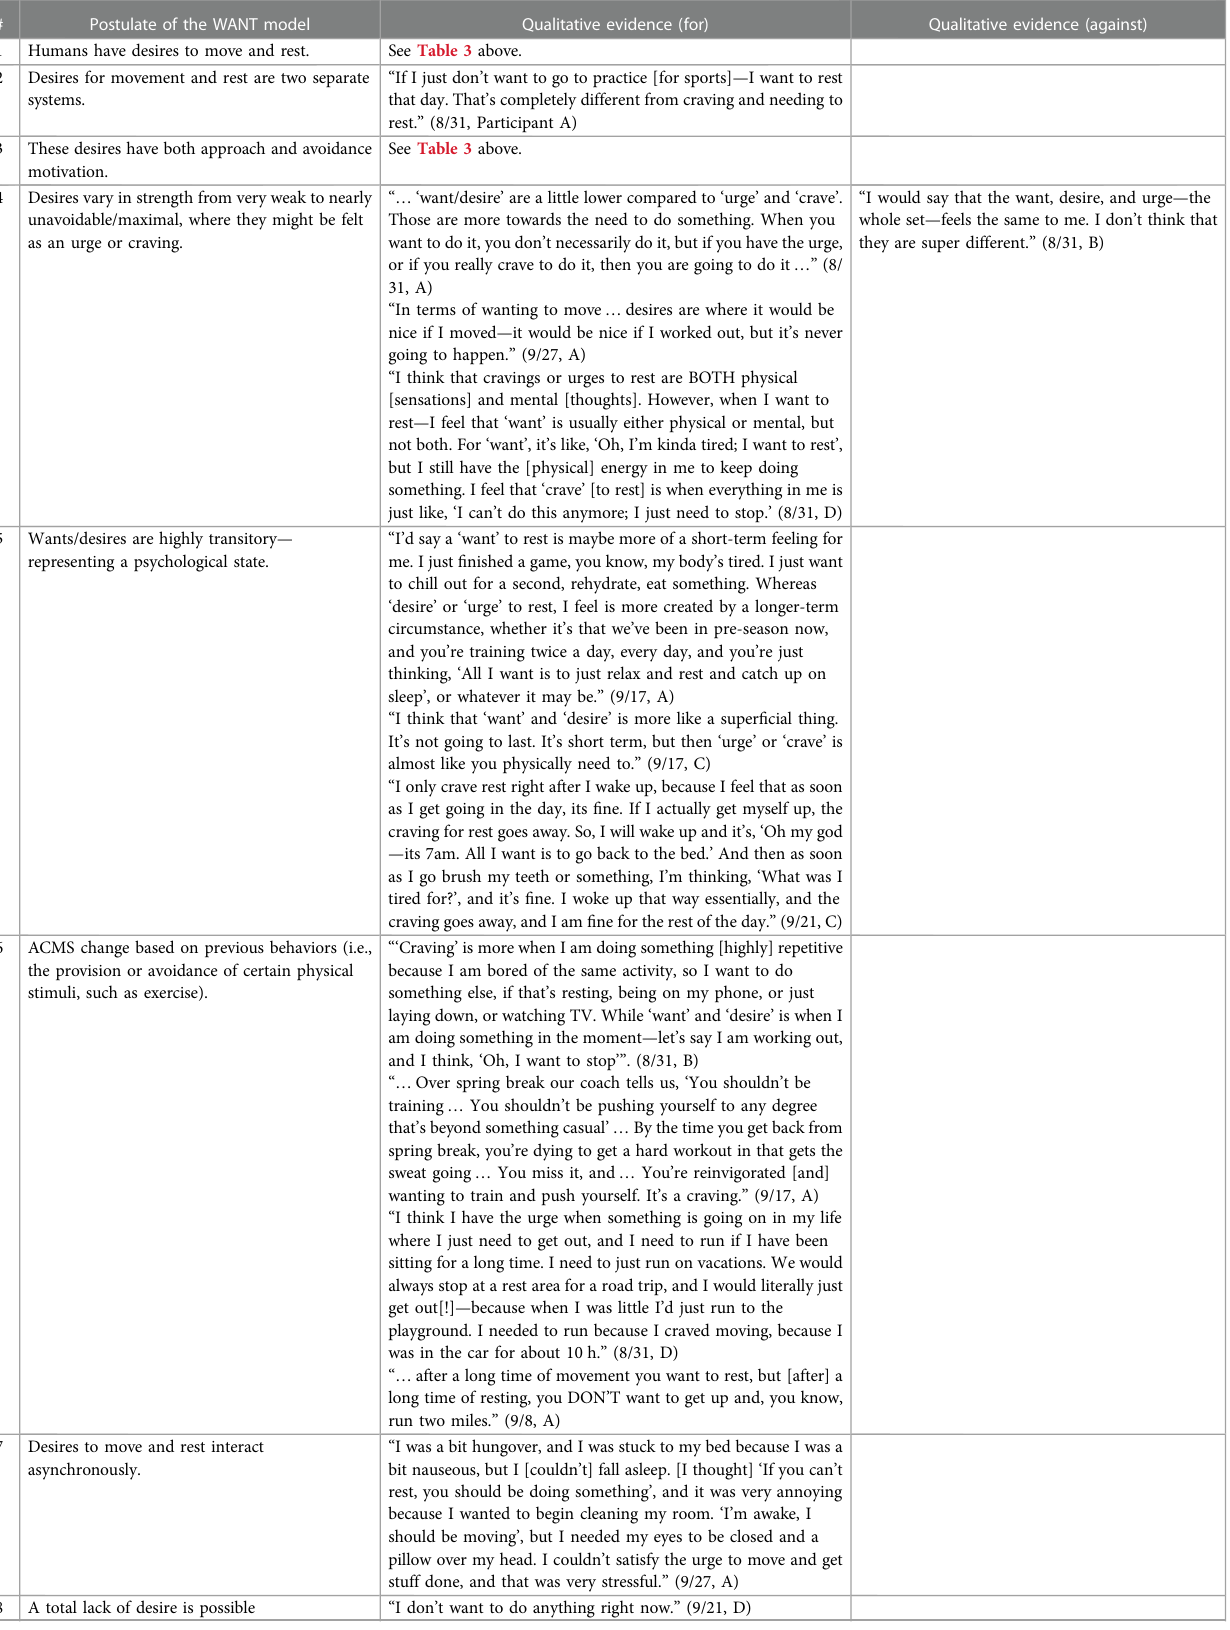
TABLE 4 Qualitative evidence for the WANT